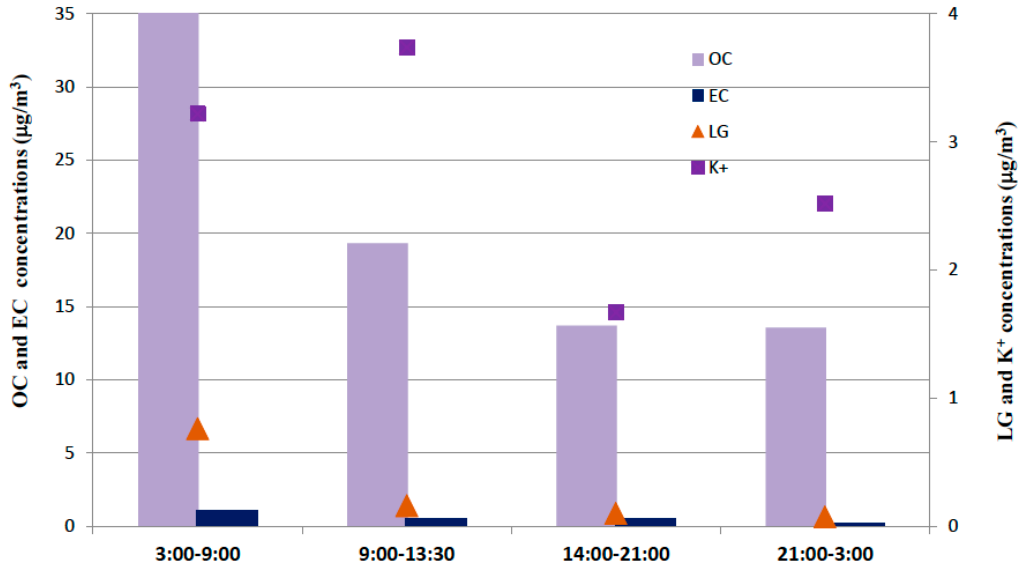
Figure 7. OC, EC, LG and K + mean concentrations for each sampling interval.